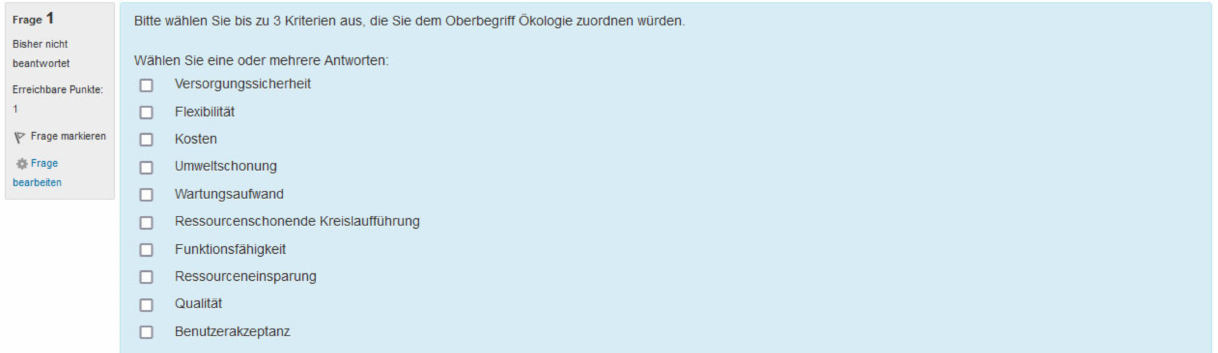
Figure 6. Example screenshot of the interface for conducting elementary interactions provisionally as part of the case study (moodle Test